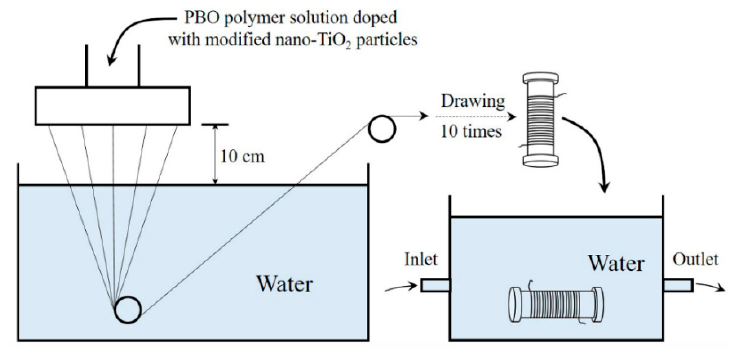
Figure 3. The procedure of dry-jet wet spinning of PBO fibers.